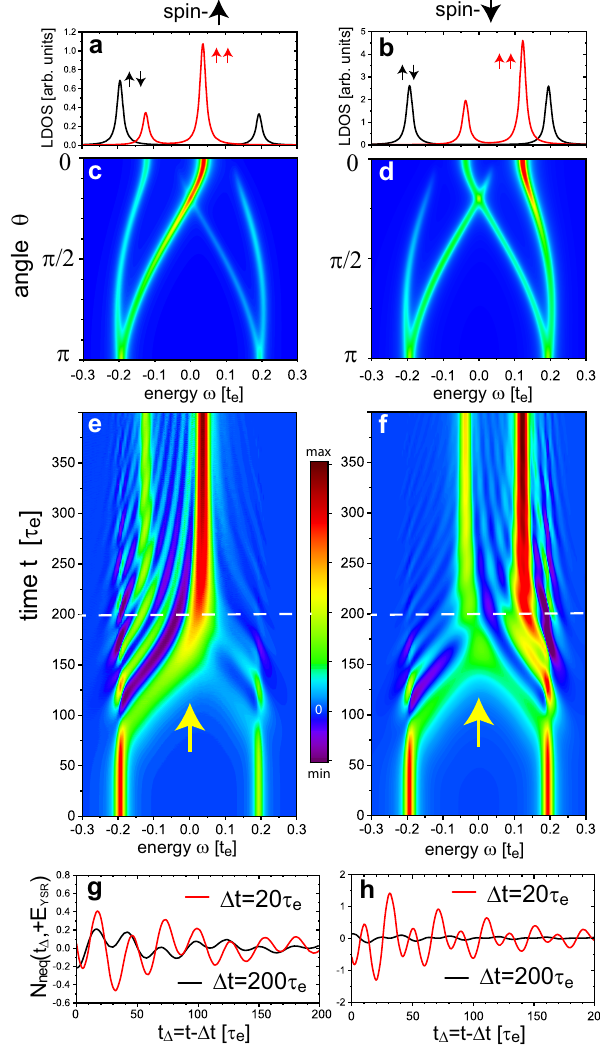
Fig. 3 Twisting a spin dimer. Equilibrium a spin- ↑ and b spin- ↓ local density of states (LDOS) for parallel ( ↑↑ ) and antiparallel ( ↑↓ ) alignment of the spins of two magnetic impurities, located on nearest- neighbor sites. The LDOS is computed at the site of the spin- ↑ magnetic impurity. Quasi-static evolution of the c spin- ↑ , d spin- ↓ LDOS as a function of the angle θ between the two magnetic moments. Spin-resolved non-equilibrium local density of states N neq ( σ , t , ω ) for e σ = ↑ , and f σ = ↓ arising from the relative rotation of the impurity moments. The colorbar represents the normalized N neq . N neq ( σ , t Δ , ω ) for g σ = ↑ , and h σ = ↓ as a function of the time after the perturbation t Δ (see text). The results for N neq were obtained for a 24 × 24 site real space